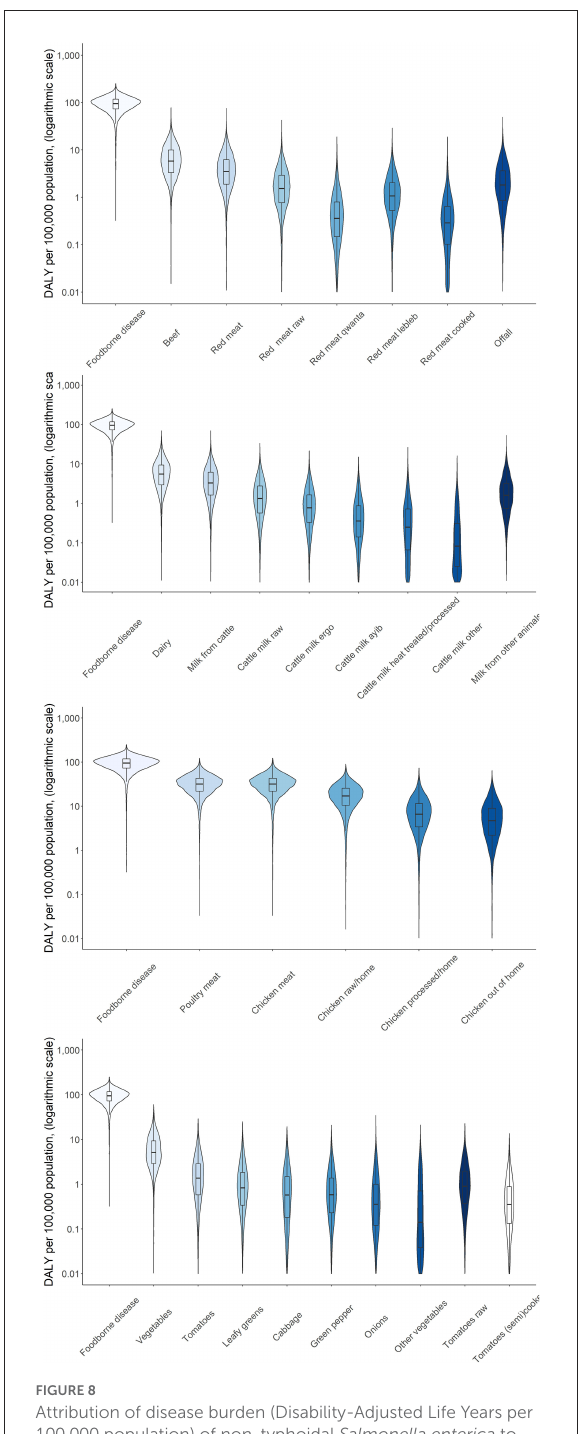
FIGURE8 Attribution of disease burden (Disability-Adjusted Life Years per 100,000 population) of non-typhoidal Salmonella enterica to food types and food products in Burkina Faso in 2017. See Figure 1 for explanation of violin